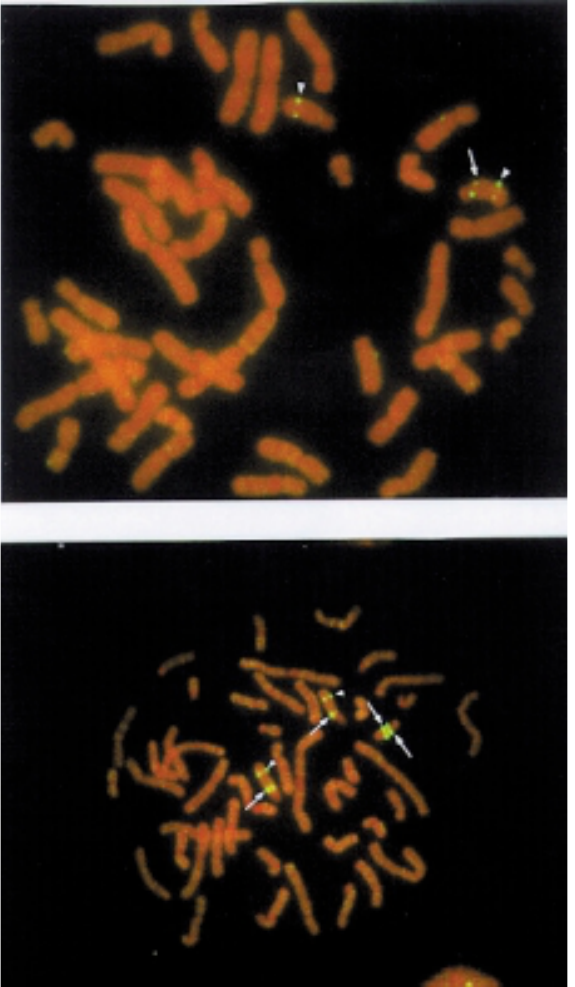
Figure 3 - FISH with GABRB3 probe (arrows) shows (a) a deletion and (b) a duplication in an inv dup(15). The signal of a control probe located at 15q22 is seen (arrowheads).